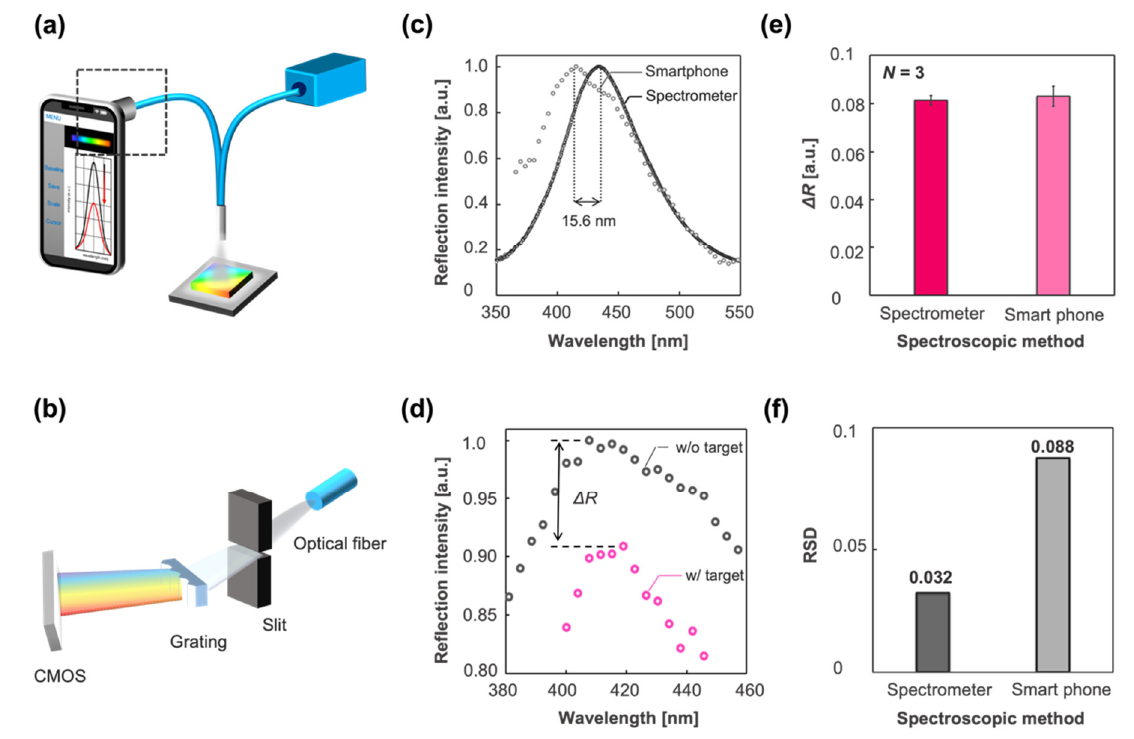
Figure 7. Smartphone-based spectrometric system vs. spectrometer-based system. ( a ) Schematic illustration of the smartphone-based optical setup. ( b ) Smartphone-based spectrometric part indicated by square dashed line in ( a ). It was composed of a slit, grating, and CMOS sensor of the iPhone 11. ( c ) Reflection spectrum of the IPCF obtained by the spectrometer-based system (black circle) and smartphone-based system (gray circle). The peak wavelength was different by 15.6 nm in this case. ( d ) Reflection spectra of the IPCF sensor (gray circle) and those after incubation in spike-protein-containing (1 ng/mL) A. saliva sample solution (pink circle). ( e ) Response to the spike protein in A. saliva (1 ng/mL) measured by the spectrometer-based system (magenta bar) and smartphone-based system (pink bar) ( N = 3). ( f ) Relative standard deviation (RSD) of the response in ( e ) (black bar: spectrometer; gray bar: smartphone).